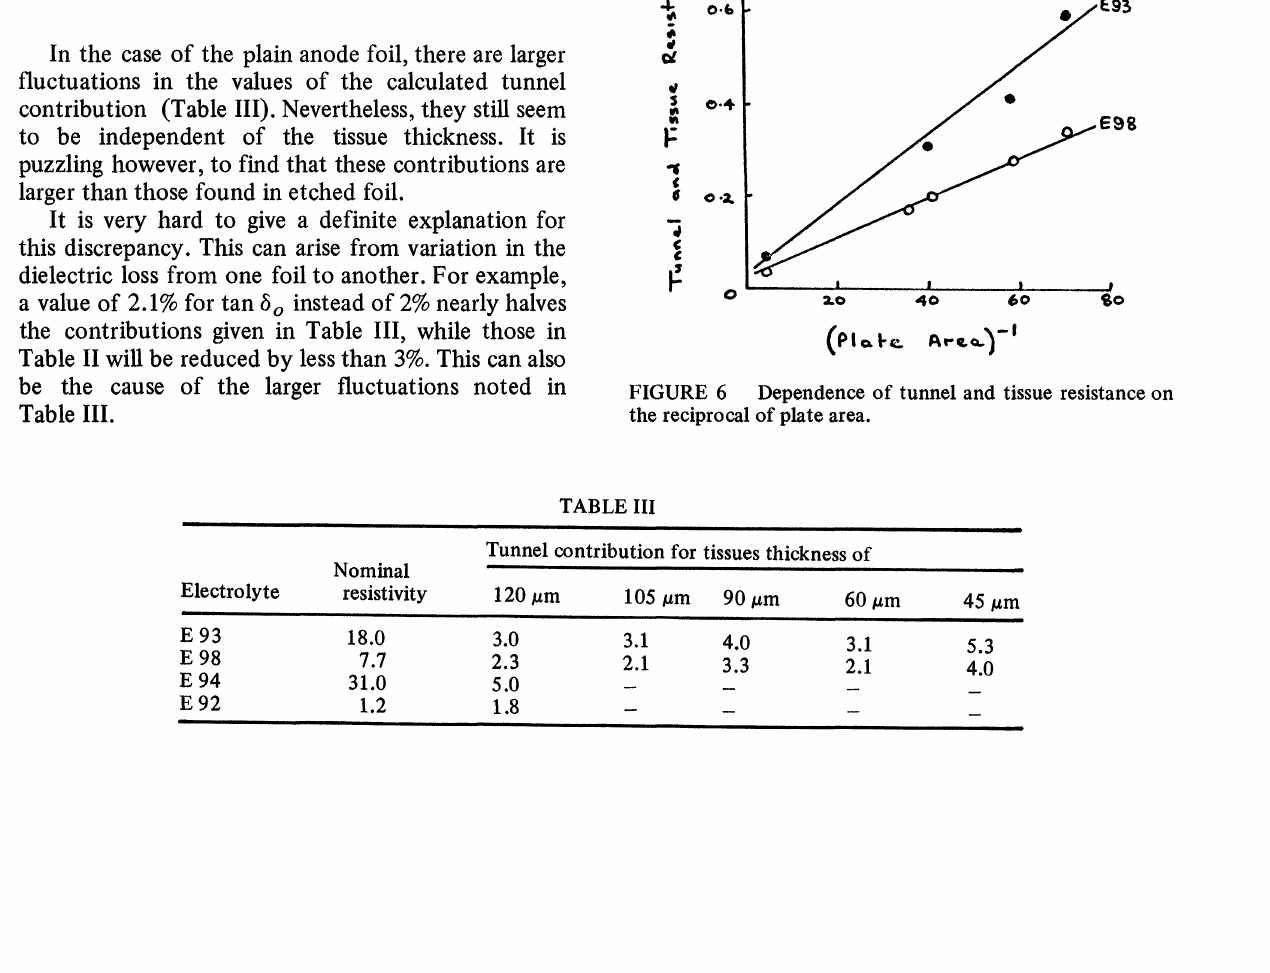
Dependence of tunnel contribution on re- sistivity of electrolyte.